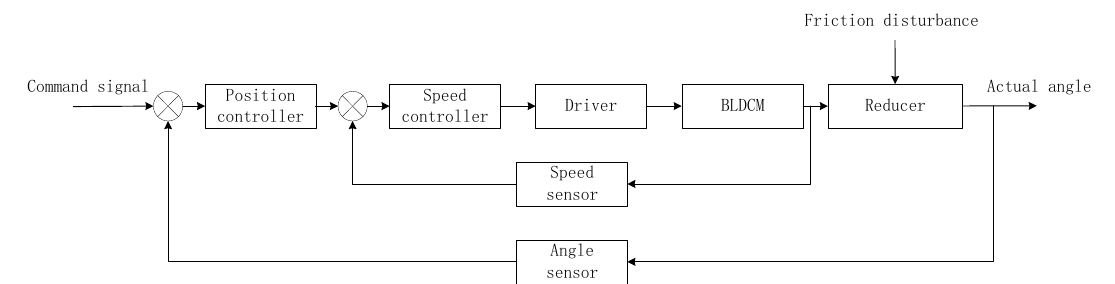
Figure 1. Structure diagram of the electromechanical actuator (EMA) system.